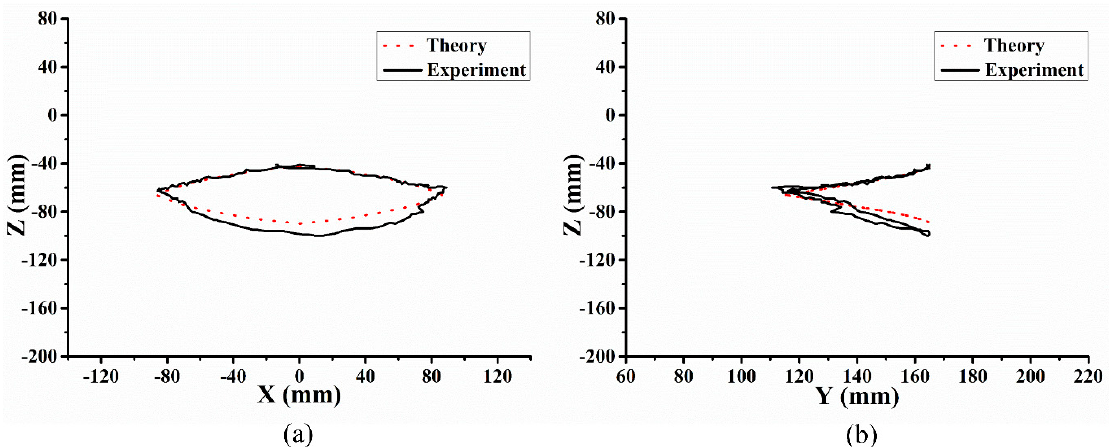
Figure 17. Experimental and theoretical trajectory curves of point f : ( a ) in X–Z plane; ( b ) in Y–Z plane.